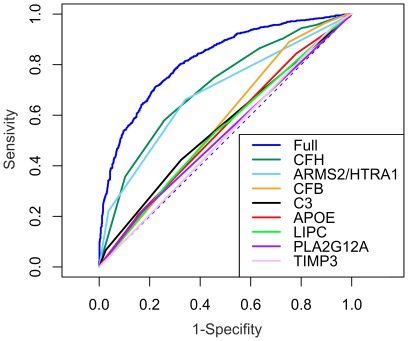
Area-under-the-curve of the receiver operating characteristic for the 13-SNP genetic risk score and by gene locus.Observed AUC was 0.820 and the locus-specific AUCs were 0.513, 0.524, 0.536, 0.547, 0.555, 0.571, 0.686 and 0.710 from bottom to top.